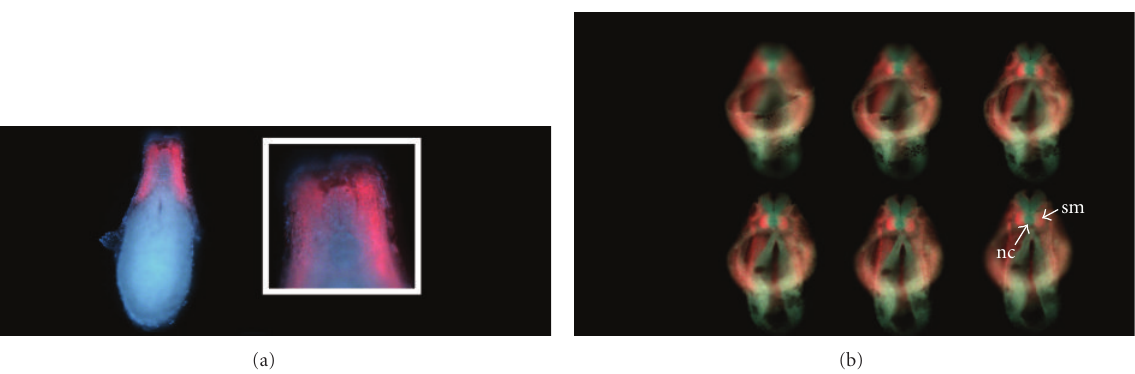
Figure 2: QD-streptavidin staining of LTBP1 compares favorably with the published staining achieved using standard chromogenic protocols in the deeper structures of the embryo [1]. (a) A transverse section from a whole mount in situ indicating the LTBP1 transcript expression pattern using QD705 nm streptavidin. The somitic staining obtained using QDs is identical to the published data using the chromogenic protocol [1], showing that the QD-streptavidin solution can penetrate and stain the deep areas of the somites. (b) A series of transverse optical sections of a QD-streptavidin-stained embryo for the LTBP1 message. The optical sections reveal that the staining previously identified as notochord by the chromogenic protocol is in fact somitic mesoderm flanking the notochord (nc: notochord, sm: somatic